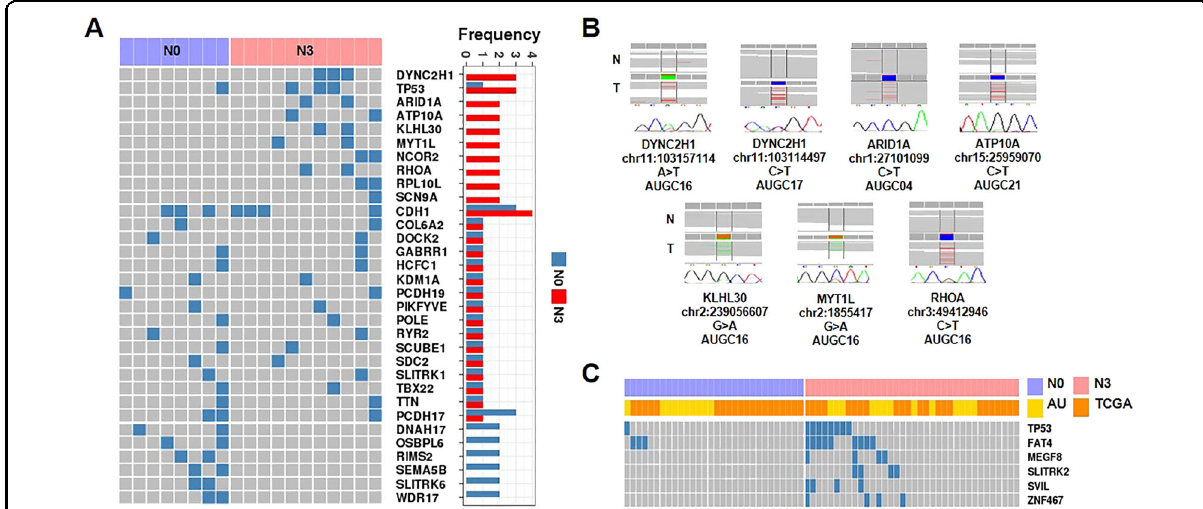
Fig. 4 Comparison of recurrent mutations in N0 and N3 tumors. a A heatmap showing 32 recurrent SDMs in DGC. A bar plot indicating mutations of N0 (red) and N3 (blue) tumors. Rows are ordered by the differential frequency between N0 and N3 subgroups. b N3 tumor-speci fi c SDMs that were validated by the Sanger sequencing method. The read alignments were evaluated using Integrated Genome Brower (IGV) software. c A heatmap showing recurrently mutated genes in N3 tumors (Fisher ’ s exact test for N0 vs. N3, P < 0.05) compared to those in N0 tumors collected from our data and TCGA